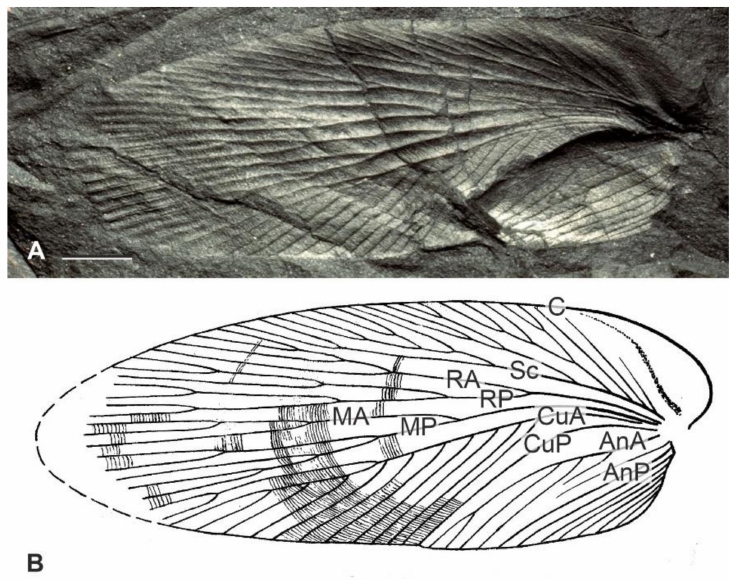
Figure 3. ( A , B )— Necymylacris heros Scudder, 1879: type species of Necymylacris Scudder 1879: